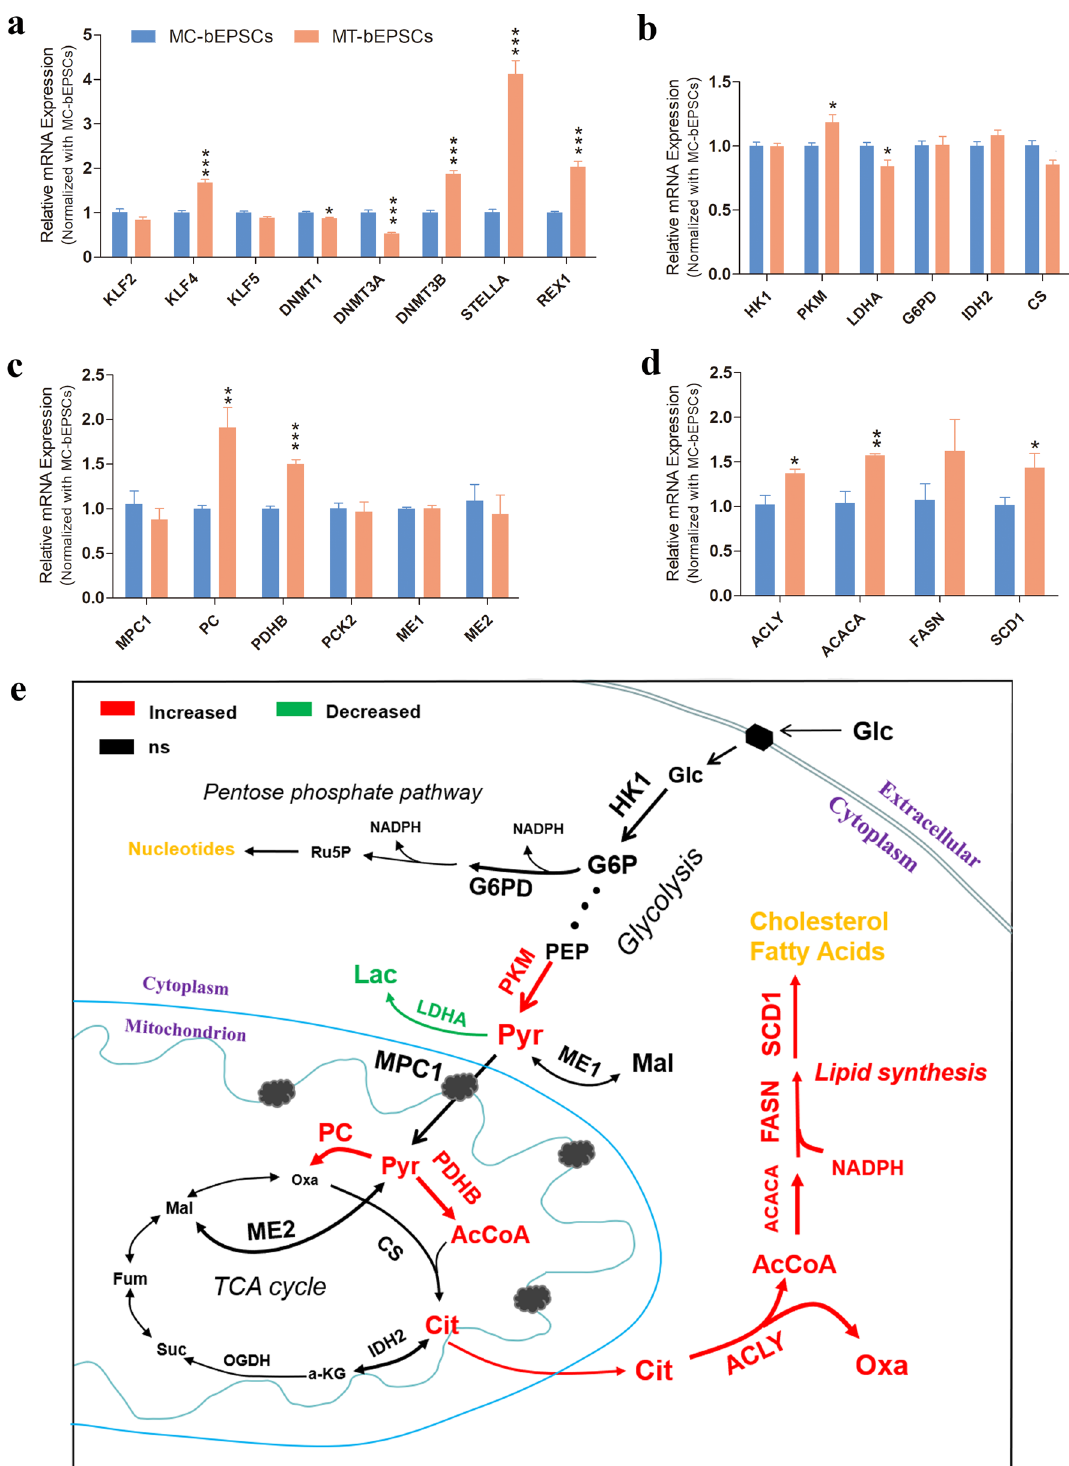
Figure 8. Characterization of central carbon metabolism in the bEPSCs grown on methanol-fixed MEFs. ( a ) RT-PCR analysis shows the expression levels of pluripotent regulatory genes, KLF2, KLF4, KLF5, DNMT1, DNMT3A, DNMT3B, STELLA and REX1, in the MC-bEPSCs and MT-bEPSCs. ( b ) RT-PCR analysis shows the expression levels of genes encoding key catalytic enzymes, HK1, PKM, LDHA, G6PD, IDH2 and CS, in major metabolic pathways. ( c ) RT-PCR analysis shows the expression levels of genes encoding the catalytic enzymes, MPC1, PC, PDHB, PCK2, ME1 and ME2, related to pyruvate metabolism. ( d ) RT-PCR analysis shows the expression levels of genes encoding the catalytic enzymes, ACLY, ACACA, FASN and SCD1, involved in de novo fatty acid biosynthesis. ( e ) The metabolic diagram shows differential expression of genes mentioned